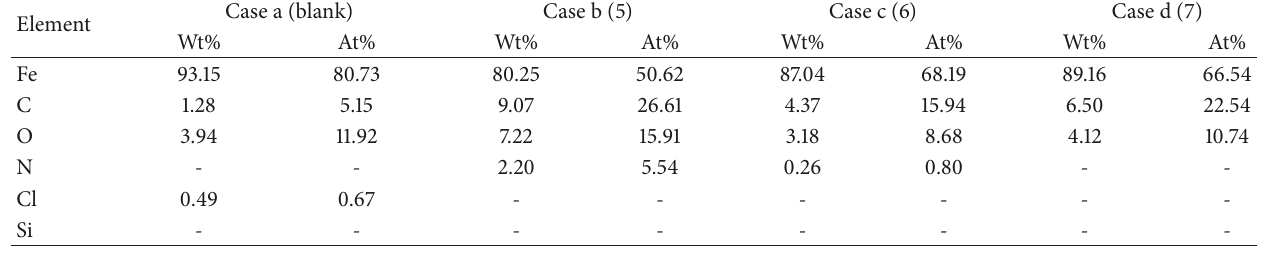
Table 7: Atomic (At) and Weight (Wt) percentages of elements obtained from EDX spectra of steel in 1 MHCl with and without inhibitors.